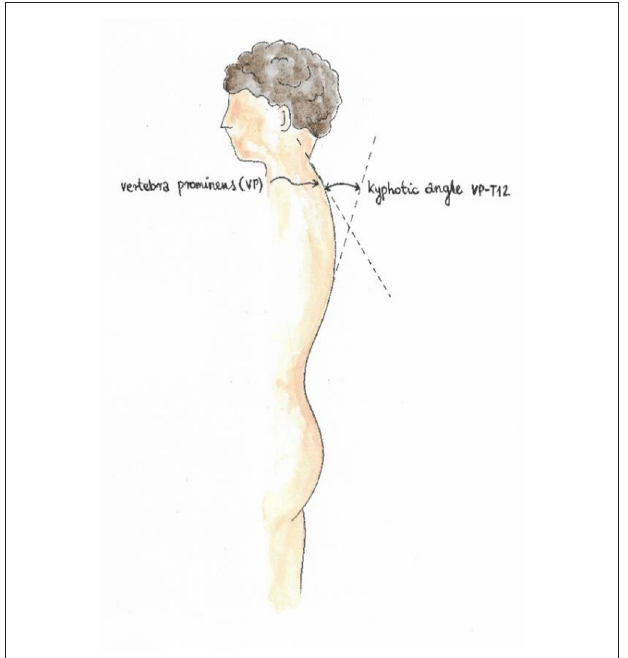
FIGURE 6 | Kyphosis angle.